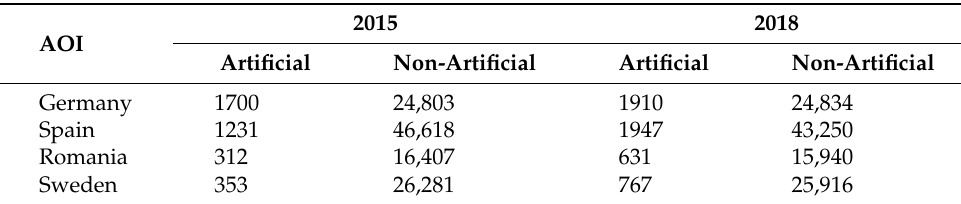
Figure 1. Regression plots between the degree of imperviousness in the reference sample and HRL IMD in the three strata—example from Germany 2018. Table 4. Number of LUCAS points classified into aggregated artificial